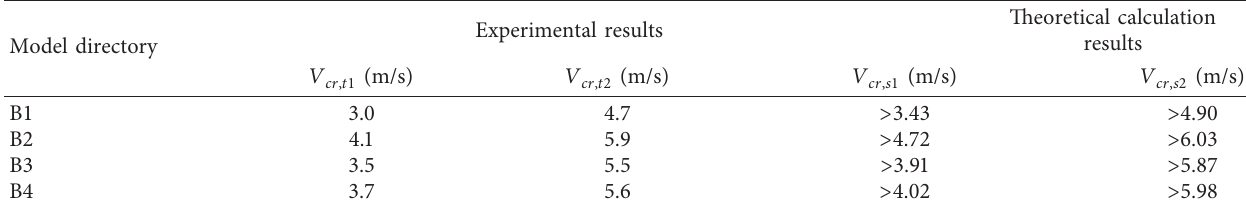
Table 2: Comparison of theoretical calculation results with experimental